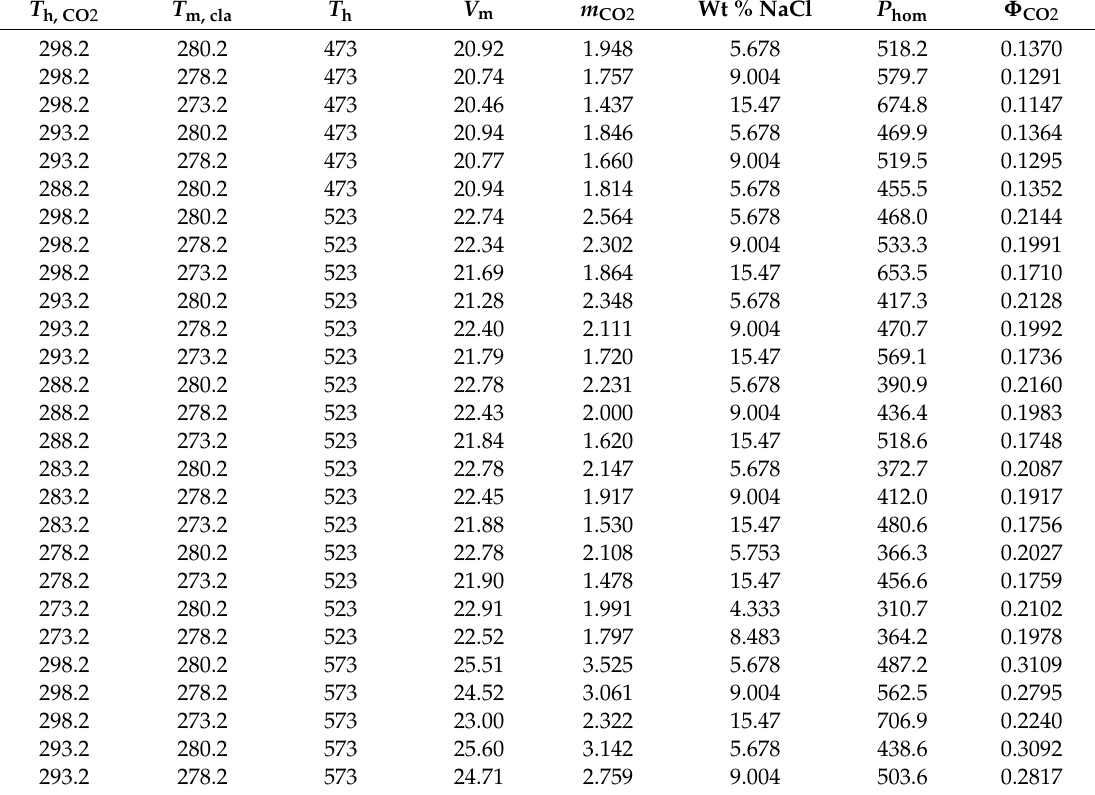
Table 3. Samples for V-x parameters of H 2 O–NaCl–CO 2 inclusions (liquid CO 2 + vapor CO 2 homogenized to vapor